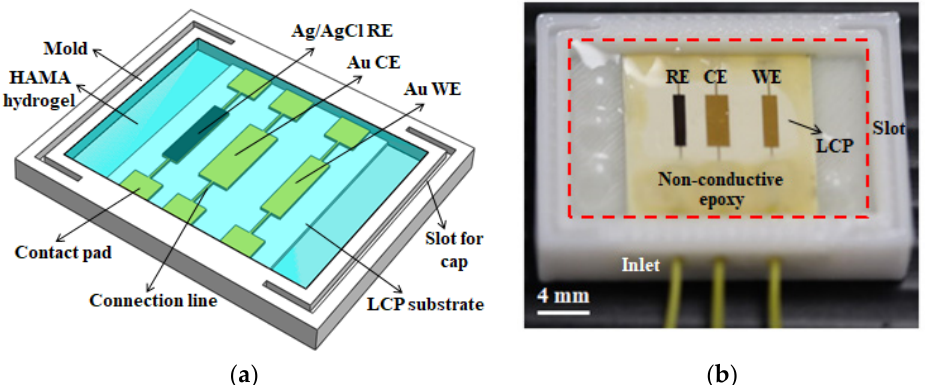
Figure 1. ( a ) Schematic drawing to illustrate the structure of the HAMA hydrogel-modified electrochemical device. ( b ) Photograph of the HAMA hydrogel-modified electrochemical device after packaging and modification, in which the cap on two sides of the polycarbonate mold is removed in order to make the swollen hydrogel visible. A transparent HAMA hydrogel layer is successfully formed on top of the electrochemical device inside the mold, which can be seen in the region marked by the dashed red